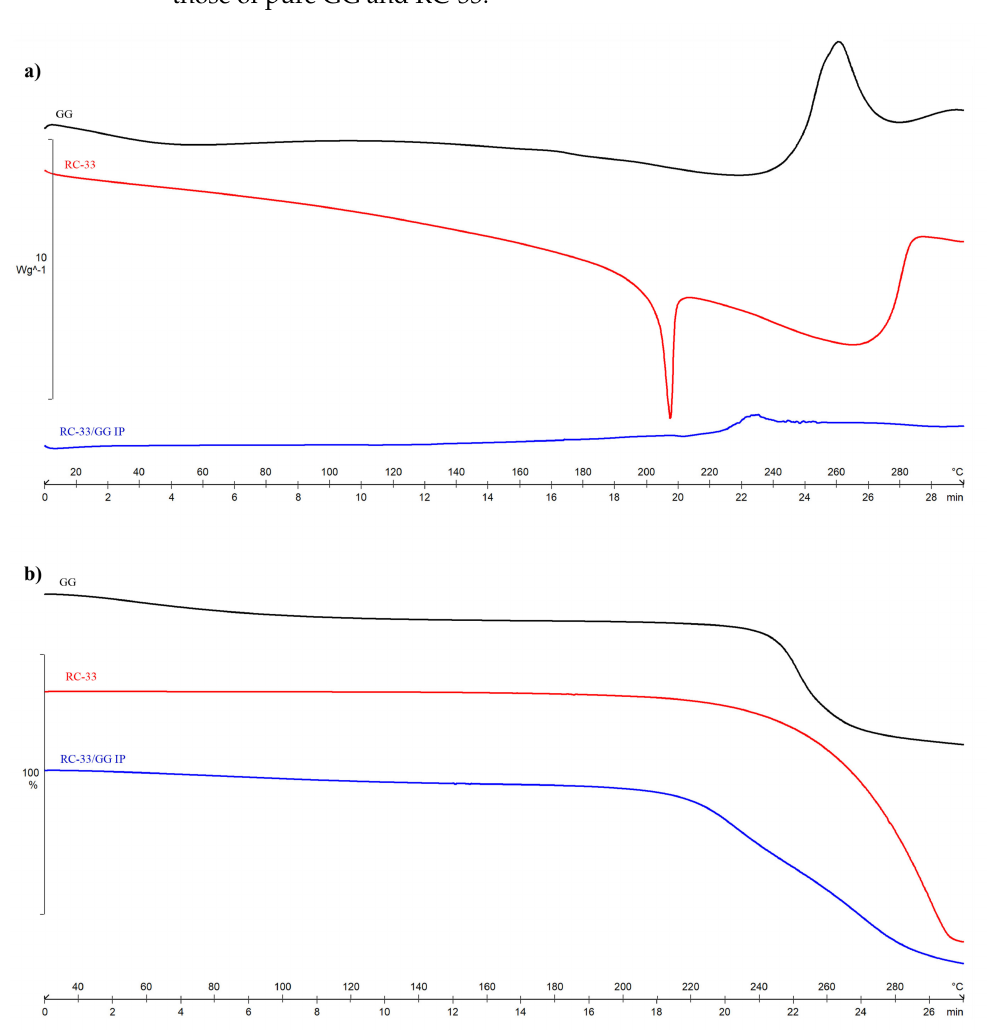
Figure 4. DSC ( a ) and TGA ( b ) curves of GG, RC-33 and RC-33/GG IP. Black line: GG, red line: RC-33 and blue line: RC-33/GG interaction product